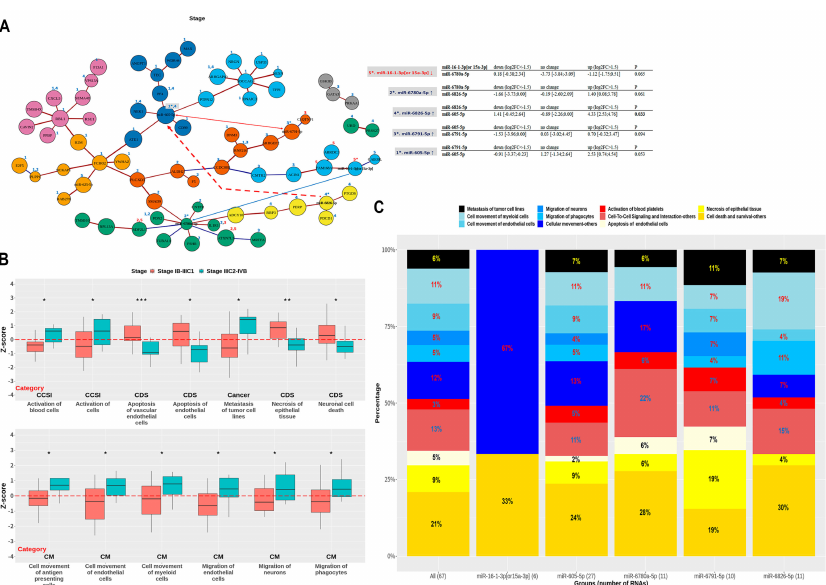
Figure 5. Simplified network of miRNA-mRNA interactions in metastasis. ( A ) A simplified network is presented from 15 RNAs involved in the shortest pathway connecting 5 mRNAs and 65 RNAs within four functional categories related to metastasis. RNAs changed by the five main miRNAs are displayed by number(s) above the vertices in red (downregulation) or blue (upregulation), and in bold ( p < 0.05) or plain ( p ≥ 0.05) fonts. Red and blue edges correspond to positive and negative correlations, respectively. ( B ) Subcategories show the difference in Z-scores according to extrapelvic metastasis; subcategories were selected based on significant Z-scores in all patients using the log 2 FC values of all 72 RNAs included in this network. * p < 0.05, ** p < 0.01, *** p < 0.001. ( C ) Biological functions associated with the 67 RNAs and five groups formed by primary miRNAs in the network are shown using boxplots. Statistical analysis was performed using the Wilcoxon rank-sum test or Kruskal–Wallis test. Downregulation and upregulation of RNAs refer to log 2 FC < − 1.5 and log 2 FC > 1.5,